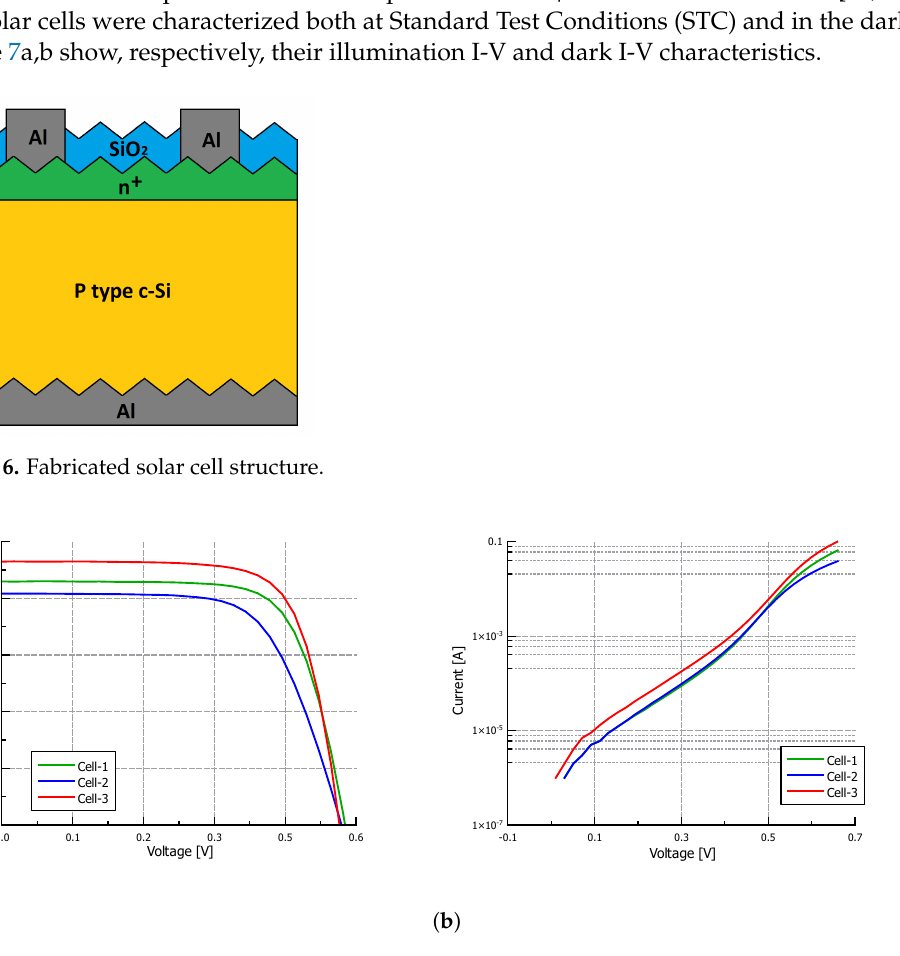
Figure 7. Experimental ( a ) illumination and ( b ) dark I-V characteristics of the fabricated solar